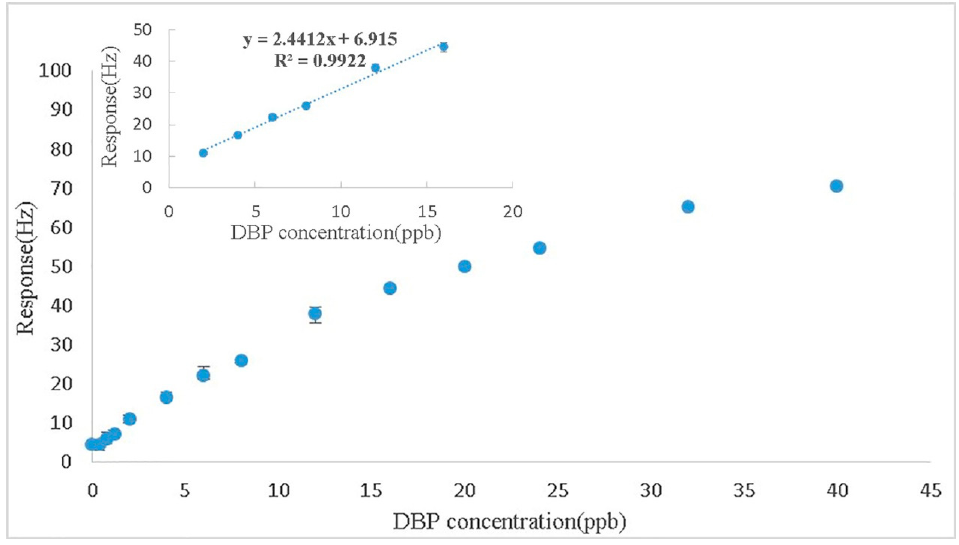
Figure 6. Calibration curve of the nano-Ni(OH) 2 -coated QCM sensor to different concentrations of DBP vapor. The inset indicates the calibration curve of the linear range.